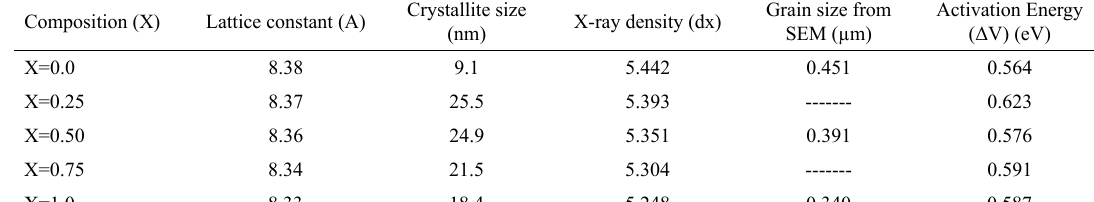
Table 1. Lattice constant, Crystallite size, X-ray density, Grain size and Activation energy of the system Zn 0.50, 0.75, 1.0)